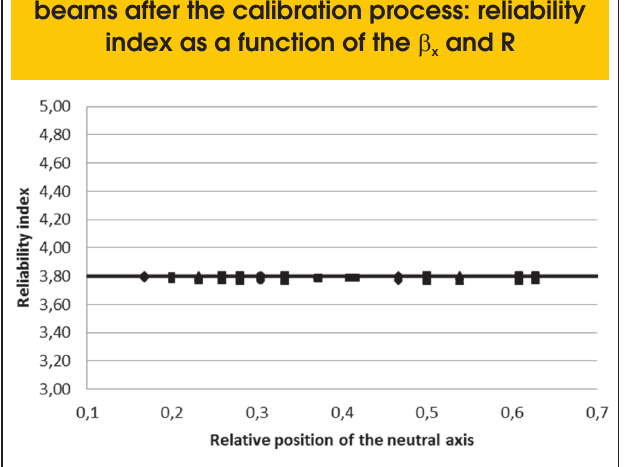
Figure 6 – Safety variability of the designed beams after the calibration process: reliability index as a function of the b and R x